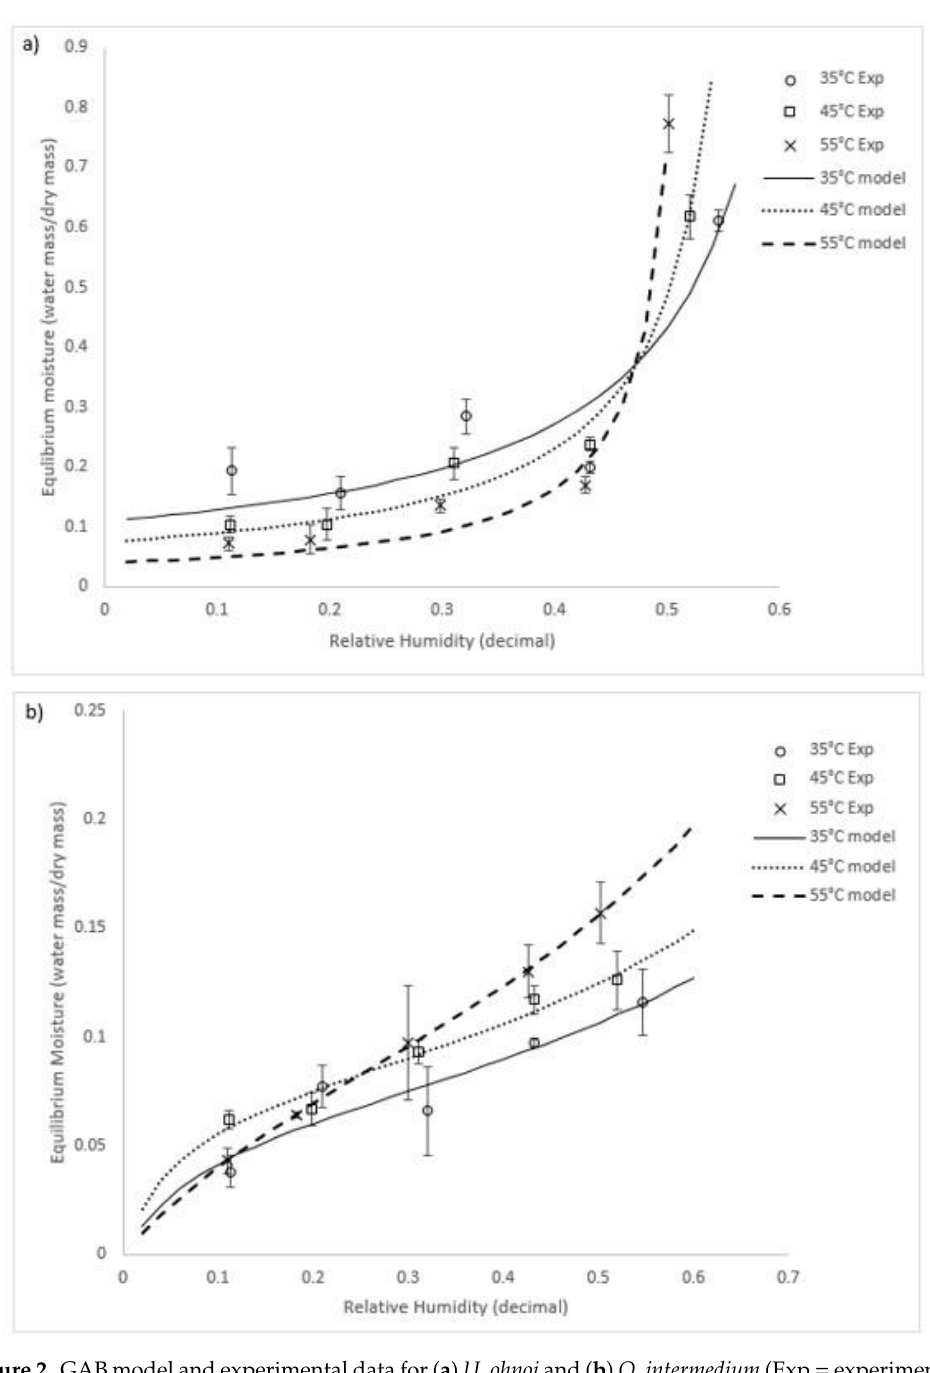
Figure 2. GAB model and experimental data for ( a ) U. ohnoi and ( b ) O. intermedium (Exp = experimental; model = modelling outcome).